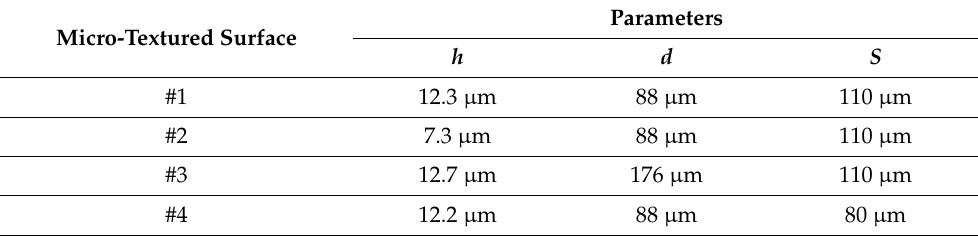
Figure 4. Surface topography of the four micro-textured surfaces fabricated by 1D UVAT: ( a ) surface #1; ( b ) surface #2; ( c ) surface #3; ( d ) surface #4. Table 2. The main parameters of micro-dimples on the surface.